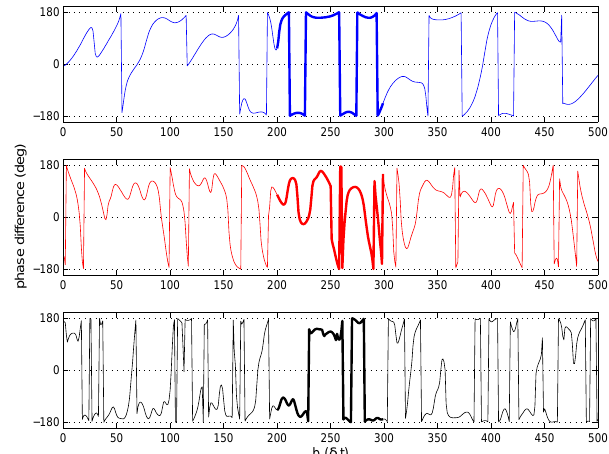
Fig. 7. Phase angle of the wavelet cross spectrum C ηu at 0.15Hz Figure 7: Fig. 7 (blue), 0.28Hz (red), and 0.5Hz (black). Wide curves of all colors highlight the period from b = 200 δt to b = 299 δt